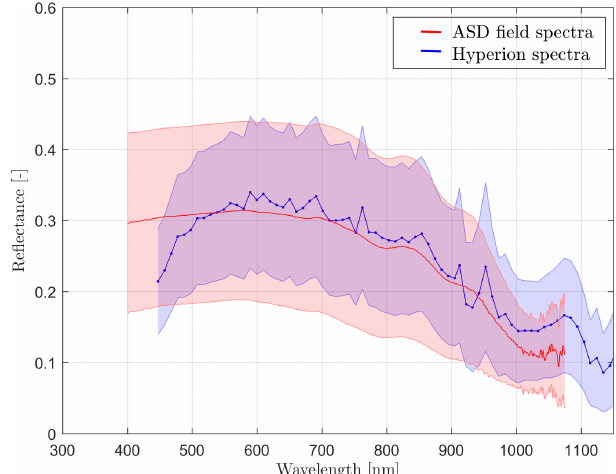
Figure 4. Comparison between ASD field reflectance spectra (red line) for the class dirty ice and Hyperion reflectance spectra (blue line) for the class bare